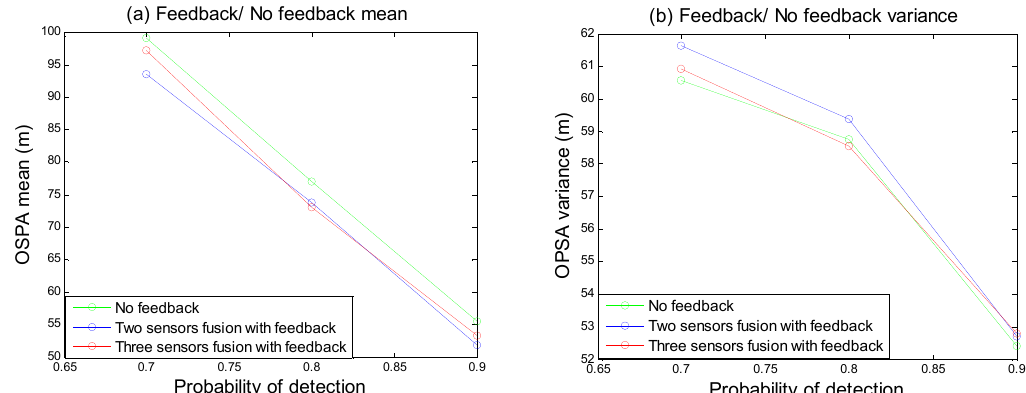
Figure 11. The OSPA of feedback/ no feedback. ( a ) is the OSPA mean of feedback or no feedback; ( b ) is the OSPA variance of feedback or no feedback.